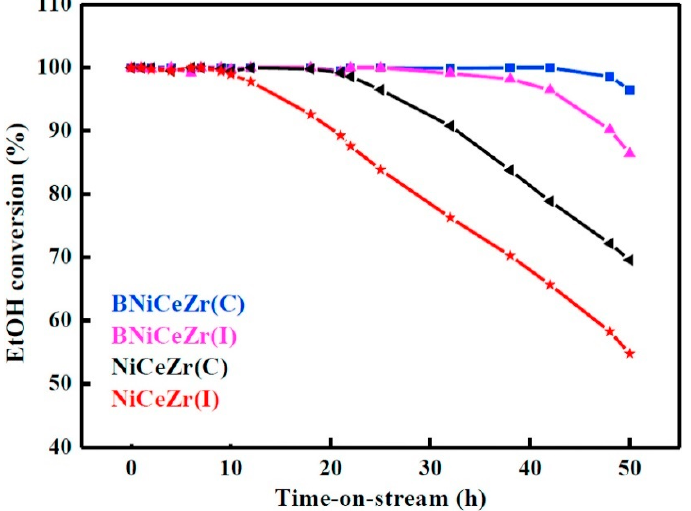
Figure 13. Influence of preparation method of Ni/Ce0.5Zr0.5O2 (C, co-precipitation; I, impregnation) on the catalytic activity of boron promoted and unpromoted catalysts. Reprinted with permission from Ref. [86]. Copyright 2022 Elsevier.